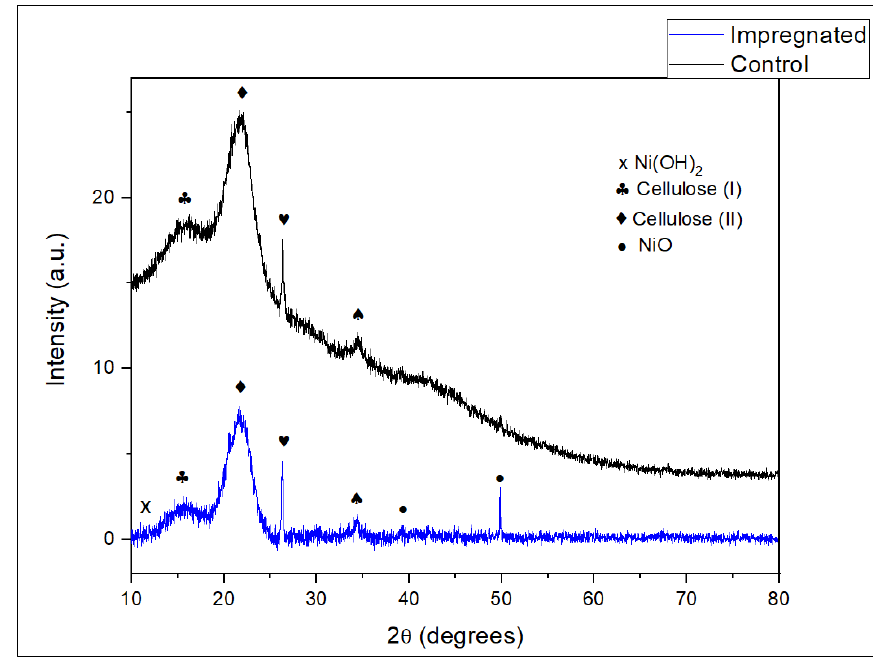
Figure 6. XRD pa tt ern of control and impregnated coconut shell samples. Figure 6. XRD pattern of control and impregnated coconut shell